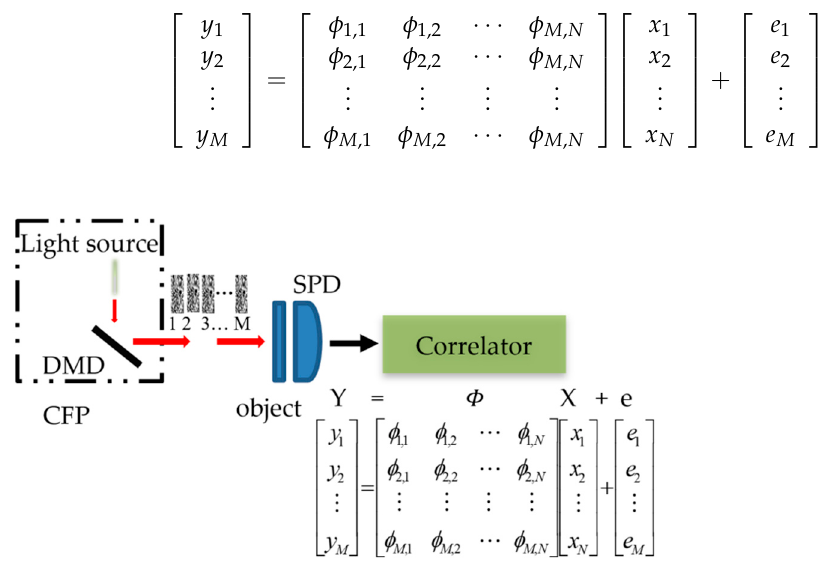
Figure 1. The single-pixel imaging setup. DMD: Digital Micromirror Device, CFP: Calculated Filed Pattern, and SPD: Single-Pixel